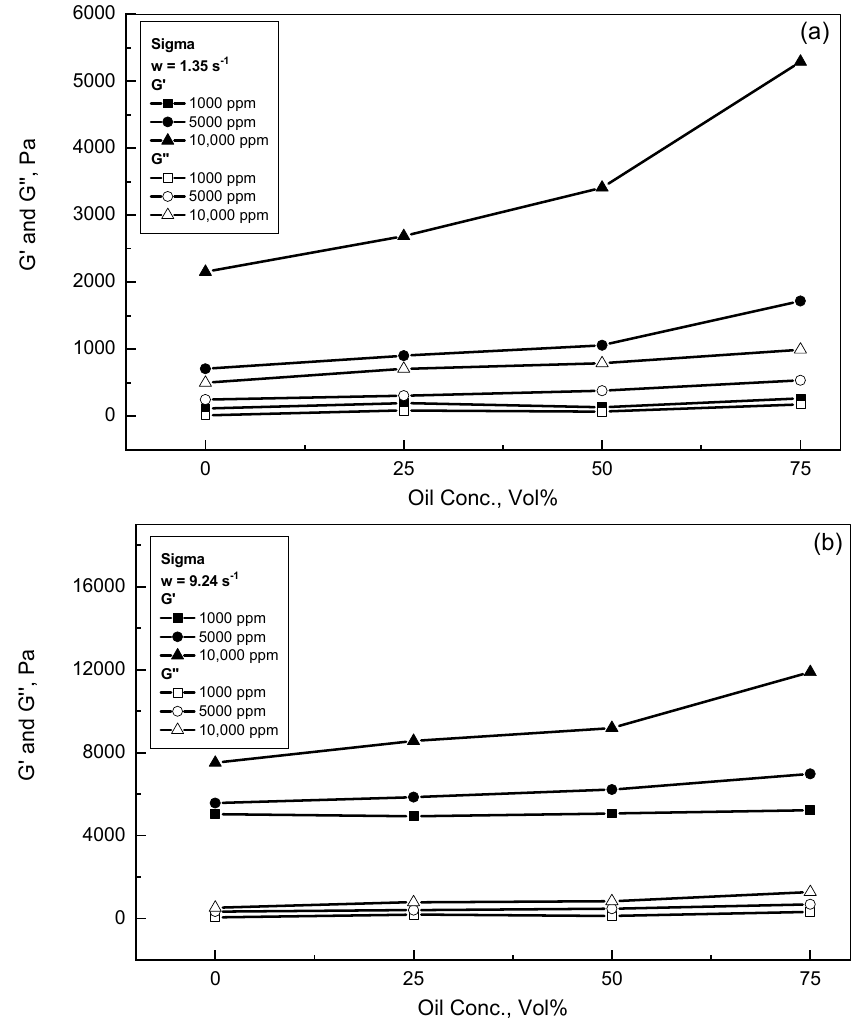
Figure 9. Effect of crude oil addition on the behavior of G’ and G’’ . ( a ) w = 1.35 s − 1 ; ( b ) w = 9.24 s − 1